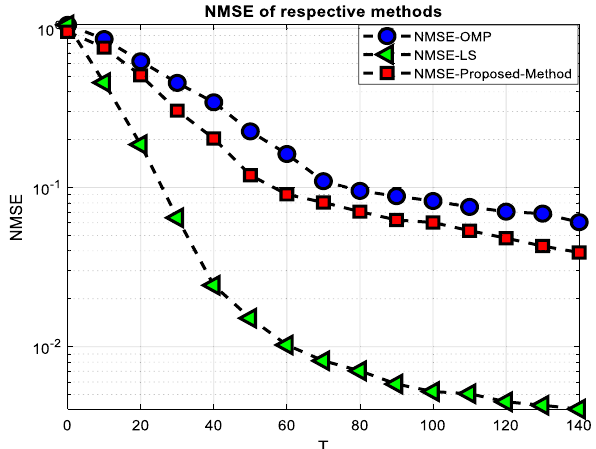
Figure 1. NMSE performance versus the pilot overhead T .